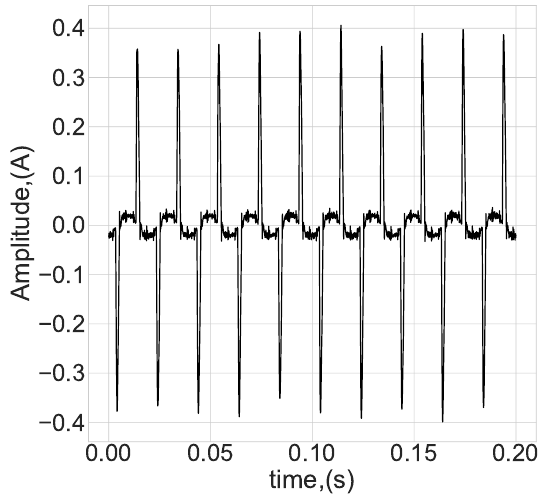
Figure 2. Illustration of the typical current consumption of